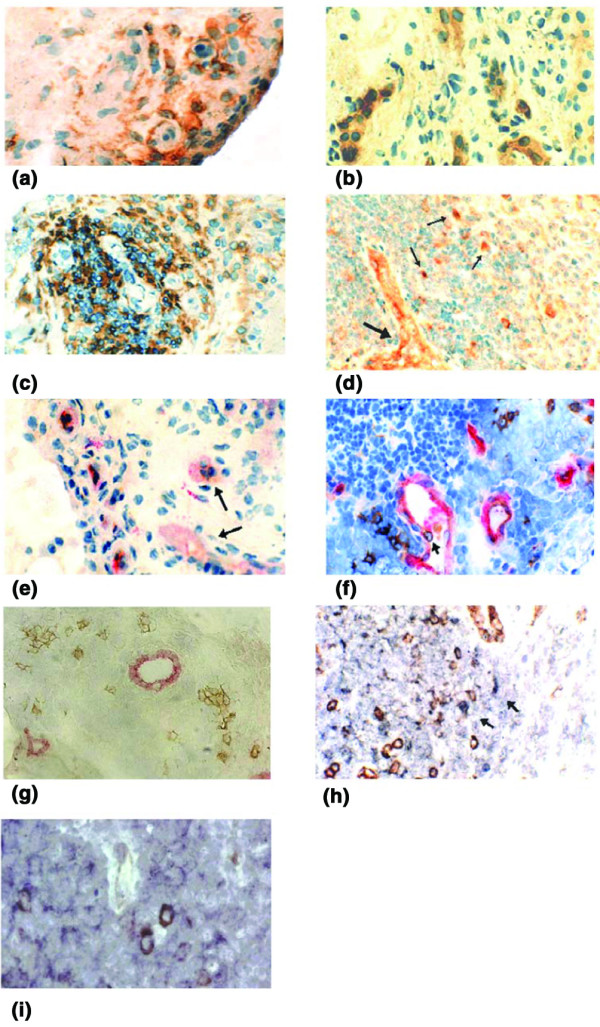
Nuclear RelB-CD123+ plasmacytoid dendritic cells (pDCs) are located in close association with cells expressing tumor necrosis factor (TNF)-α in lymphoid aggregates of rheumatoid arthritis (RA) synovial tissue. Sections of frozen normal human synovial tissue (a, b, e) or synovial tissue from a patient with untreated active RA (c, f, g) or formalin-fixed sections from a patient with active RA (d, h, i) were stained with anti-CD11c (brown, a, c), anti-CD123 (brown, b, d), or anti-TNF-α (brown, g) using an immunoperoxidase technique. For double staining, sections were stained with Ulex (red) and anti-CD123 (brown, e, f, g) or with RelB (purple) and CD123 (brown, h, i) using a double, immunoperoxidase–immunoalkaline phosphatase technique. All sections were counterstained with hematoxylin (blue) except h and i, in which the nucleus of CD123+ cells appears as a hole. The thick arrow in d identifies a blood vessel. Thin arrows denote representative CD123+ perivascular DCs (d), representative double-stained vessels (e), a CD123+ cell within a blood vessel (f), and nuclei stained by RelB (h). Data are representative of at least three separate RA donors in individual experiments. Scale bars represent 20 μm.